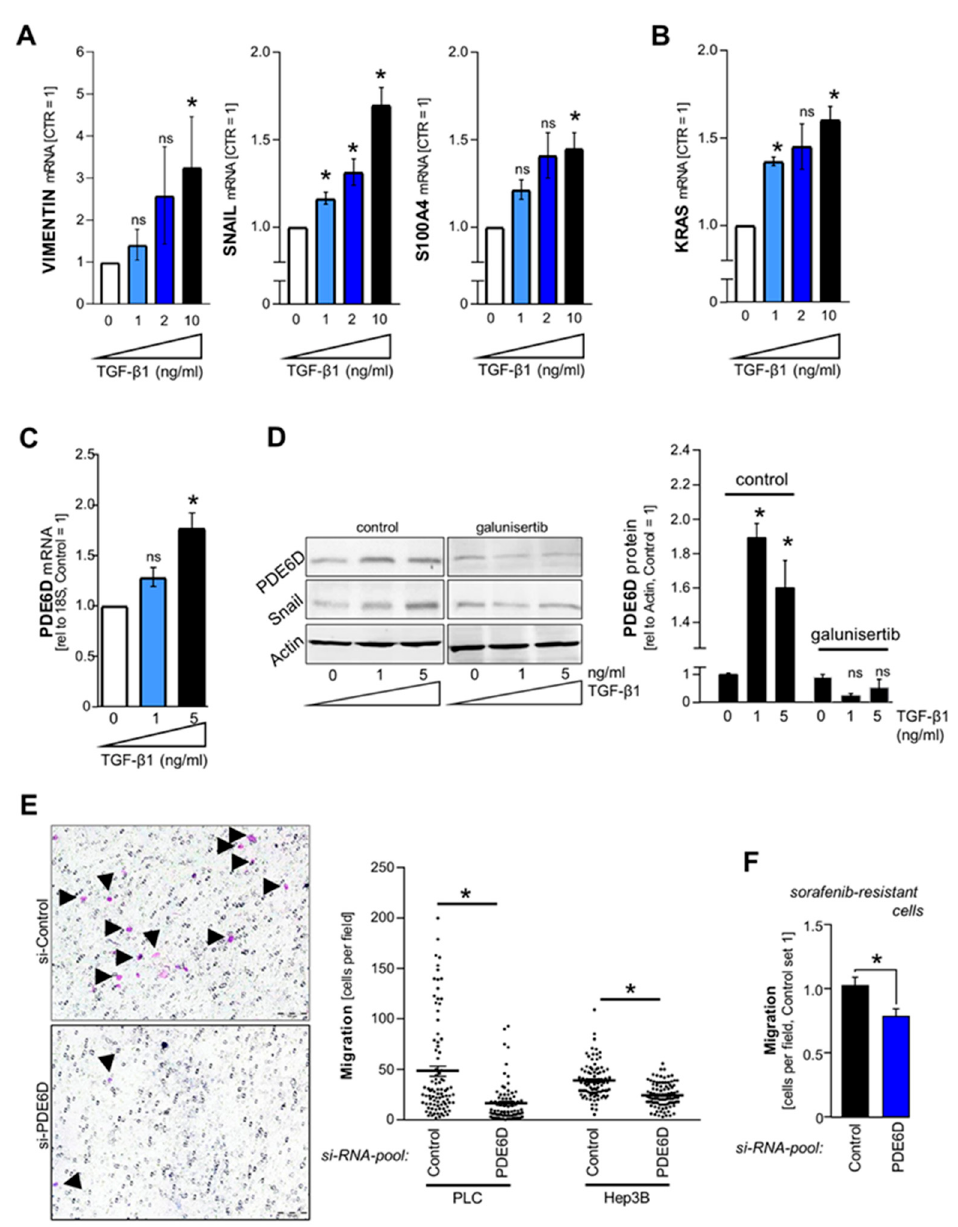
Figure 5. TGF- â -mediated regulation of PDE6D and the effect of PDE6D on HCC cell migration. ( A – C ) Quantitative RT-PCR analysis of VIMENTIN, SNAIL, S100A4 ( A ) and KRAS ( B ) mRNA levels in HCC cells (PLC) that were stimulated with different doses of recombinant human TGF- â 1 protein for 72–96 h (* p < 0.05 vs. control). ( C , D ) Quantitative RT-PCR revealing mRNA levels ( C ) as well as protein levels as quantified by Western blot analysis (including a representative Western blot image) (the densitometric values represent two independent Western blot analysis) ( D ) of PDE6D expression in HCC cells (PLC) that were treated with different doses of recombinant human TGF- â 1 for 72–96 h. ( D ) also depicts co-treatment with 15 µ M of the TGF- â -receptor-1 (TGFBR1) inhibitor LY2157299 (“galunisertib”) (* p < 0.05 vs. control). ( E , F ) Prior to Boyden chamber experiments, non-resistant HCC cells (PLC, Hep3B) ( E ) and sorafenib-resistant Hep3B cells ( F ) were transfected with si-RNA-pools against PDE6D (“PDE6D”) or the according control- si-RNA-pool (“Control”). Migration (migrating cells per visual field) as measured by Boyden chamber migration assay (duration of migration: 4 hours) is depicted as absolute cell counts ( E ) or as normalized migration ( F ) (* p < 0.05).